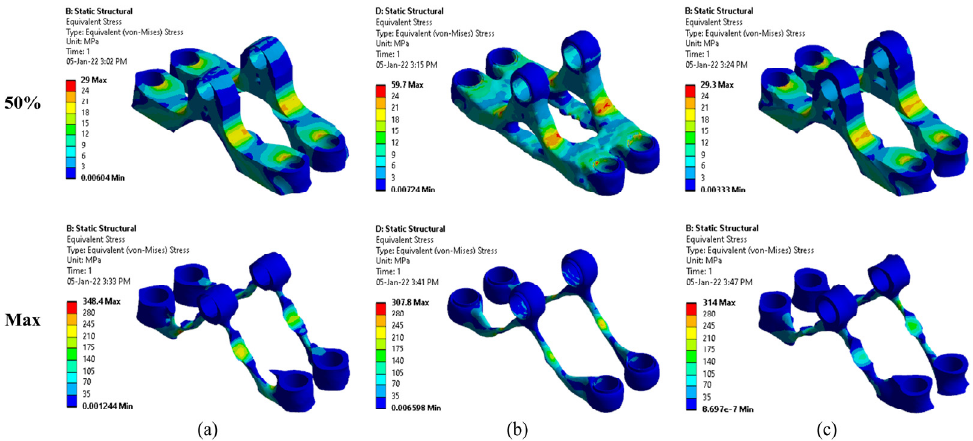
Figure 9. The validation results of the pillow bracket for 50% and maximum weight reduction in ( a ) SolidWorks, ( b ) ANSYS Mechanical, and ( c ) ABAQUS.